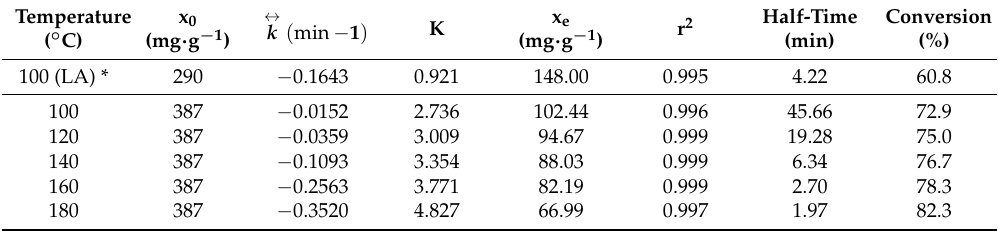
Table 2. Kinetic parameters of oligomeric lactic acid alcoholysis with respect to ethanol.